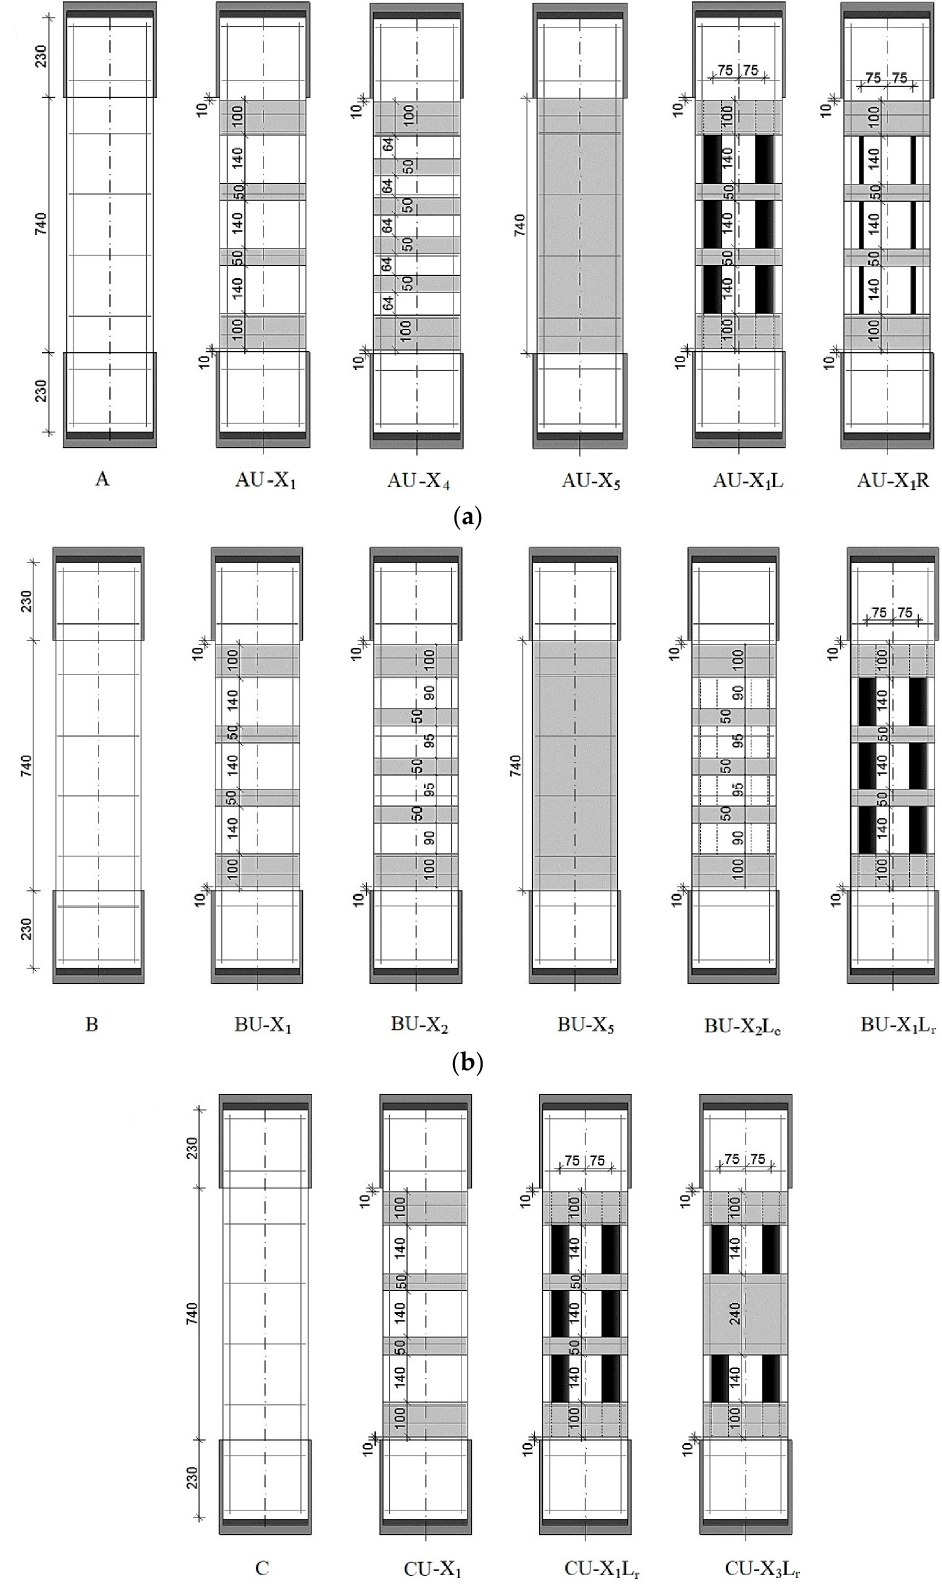
Figure 4. Variants for strengthening the columns with external transverse, longitudinal and combined composite reinforcement with an eccentricity of load application: ( a ) e 0 = 0; ( b ) e 0 = 2 cm; ( c ) e 0 = 4